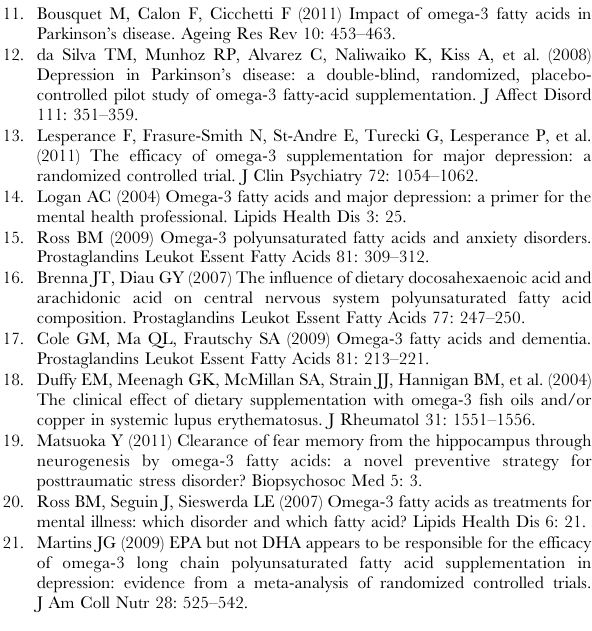
Table S1 List of primers and probes used in qPCR assay. Table S2 List of 1,142 genes of interest (GOI). The genes are identified by the Gene Name and gene symbol. The log ratio indicates the log 1.5 transformed of the average transcriptomic expressions from FD-/SD-fed mice. Table S3 Complete list of biofunction categories en- riched by 1,142 genes. For individual functional categories,